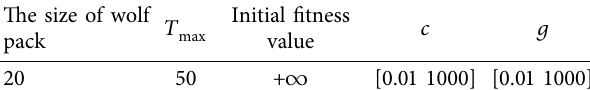
Table 1: Parameters setting for GWO-SVM